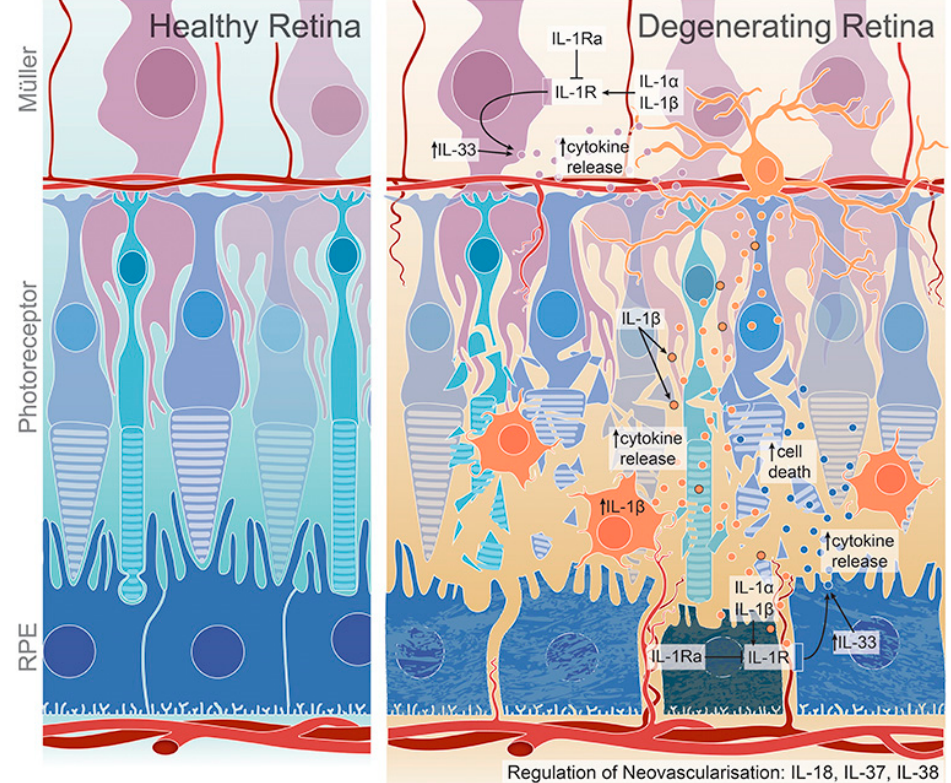
Figure 1. IL-1 family members and their role in retinal degeneration. Activated microglia/macrophages secrete IL-1 β , which further induce the release of chemokines and cytokines from Müller and RPE cells, promoting microglia/macrophage recruitment to the inflamed retina. The expression of IL-1Ra, which is a competitive antagonist for IL-1R, is dysregulated in degenerated retina. IL-33 regulates cytokine expression in dry AMD. IL-18, IL-37 and IL-38 have both pro- and anti-angiogenic effects and regulate retinal neovascularization. Adapted from Wooff et al.